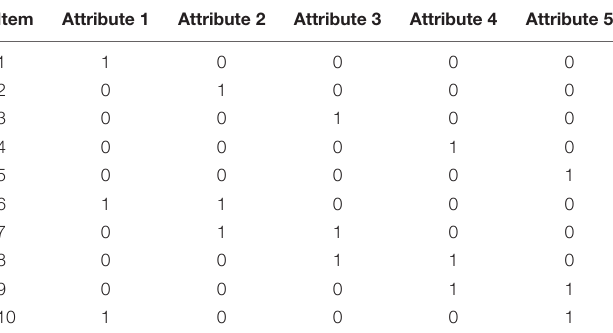
TABLE 1 | Q-matrix for the ten items in the